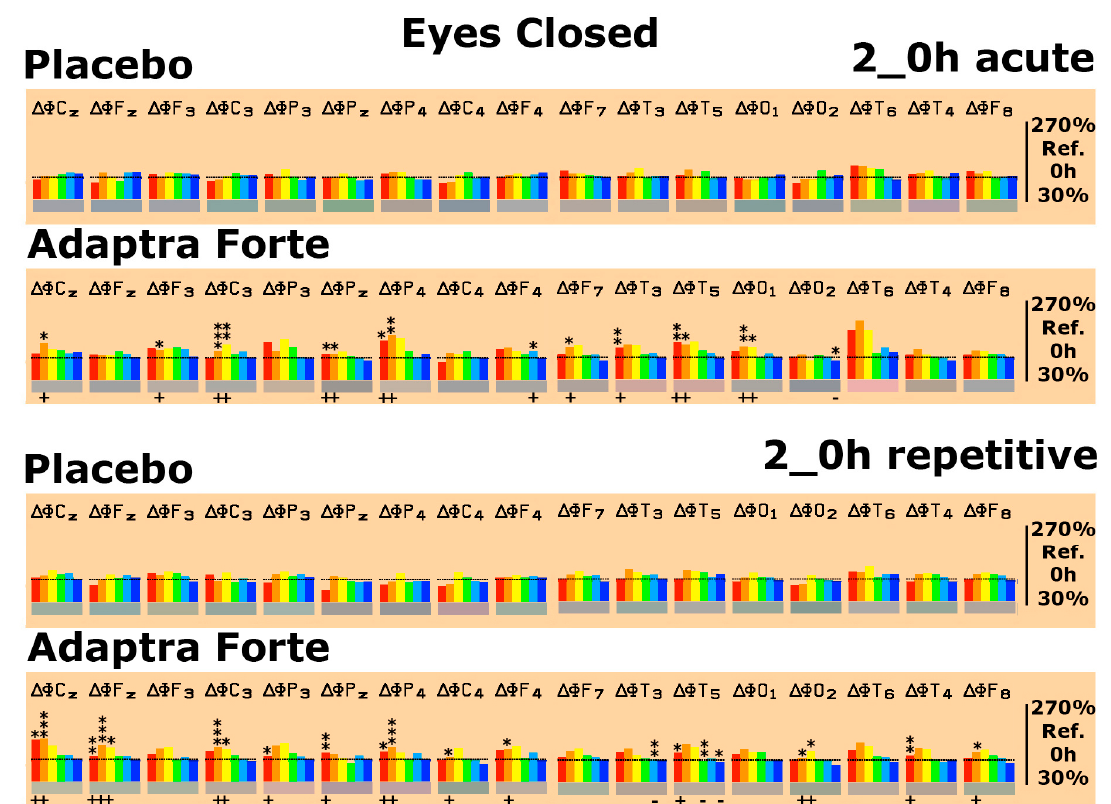
Figure 3. Spectral power differences under the eyes closed recording condition on the first experimental day (acute) and on the last experimental day (repetitive) with administration of placebo or Adaptra ® Forte in all brain regions as represented by the electrode positions. C = central, p = parietal, O = occipital, F = frontal, T = temporal. * p < 0.12; ** p < 0.05; *** p < 0.01.